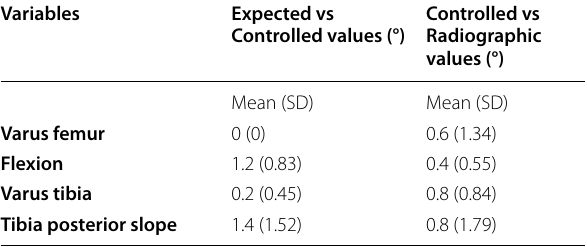
Table 3 Differences in absolute values as mean and standard deviation (SD) between expected and controlled values and between controlled and radiographic values Variables